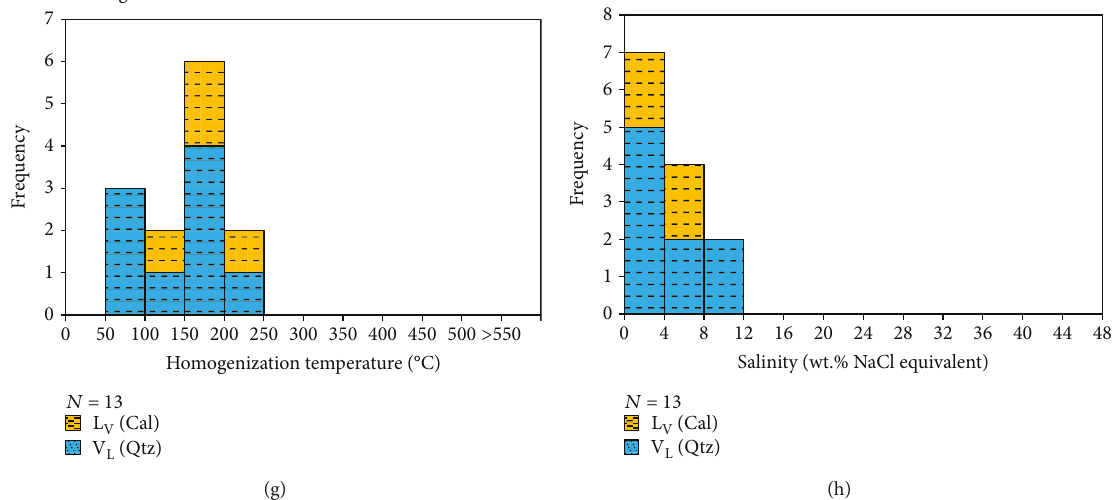
Figure 10: Histograms of fi nal homogenization temperatures (Th) and salinities for all inclusion types in di ff erent host minerals and stages. Prograde skarn stage (a), (b). Retrograde skarn stage (c), (d). Quartz-Sul fi de stage (e), (f). Carbonate stage (g), (h). Grt: garnet; Di: